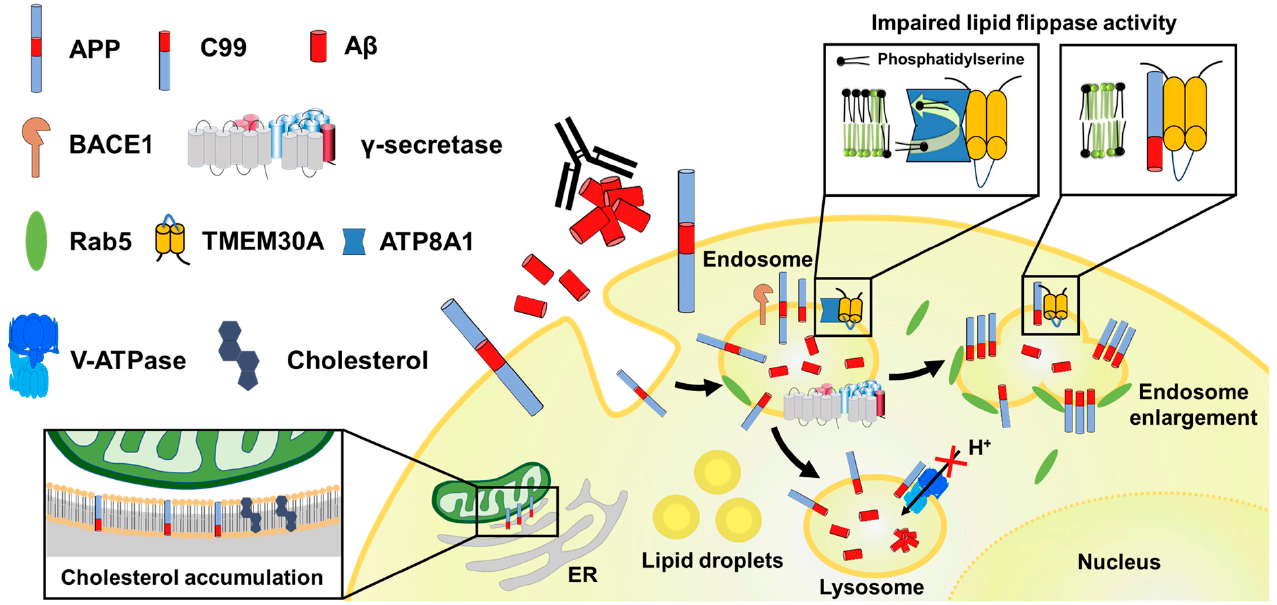
Figure 5. Diagram showing the intracellular pathology caused by C99 accumulation. Endolysosomal damage due to abnormal activation of Rab5 and decreased lipid flippase activity, autolysosomal damage due to decreased V-ATPase activity, and cholesterol intracellular transport defects induced by C99 accumulation are illustrated.